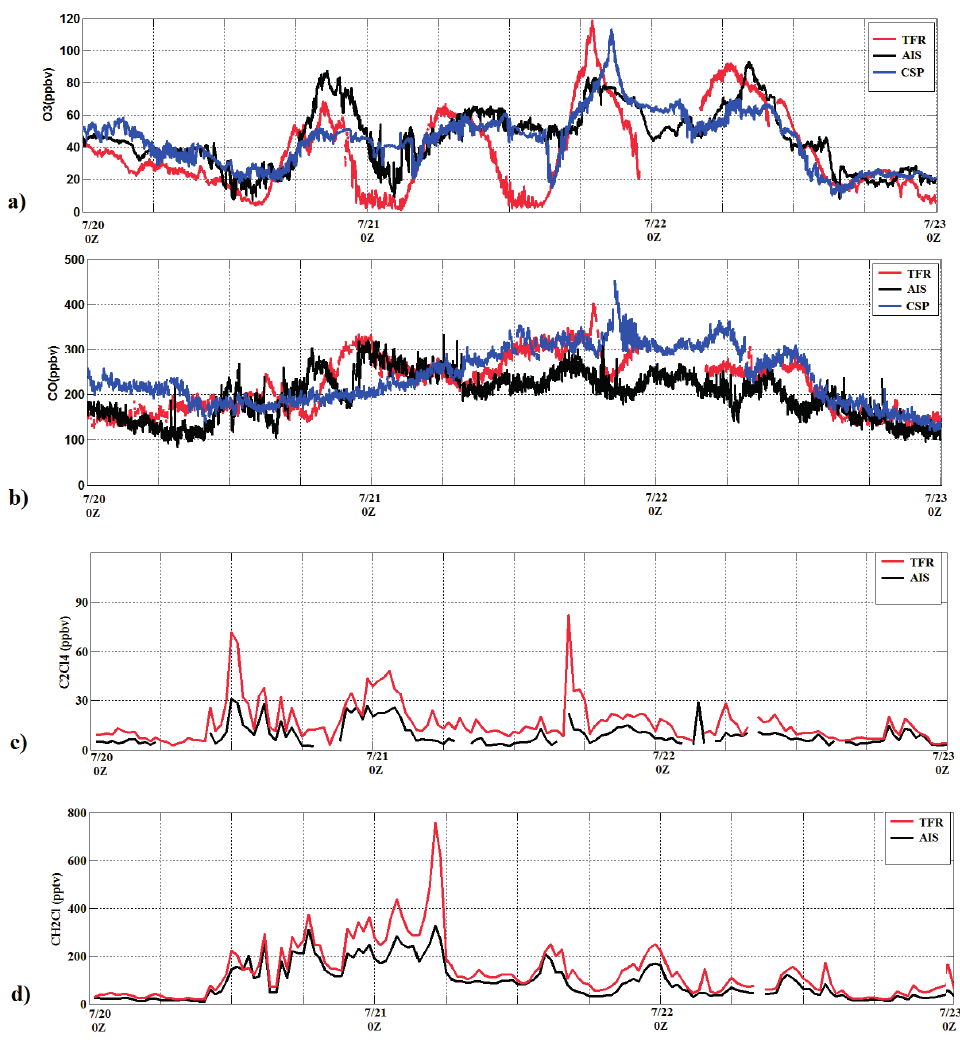
Figure 11. Surface observations from the AIRMAP stations during the transit of the NYC plume. Shown are measurements of ( a ) O AIS (black), and CSP (blue). Canister observations of ( c ) C TFR and AIS are also shown for the same time